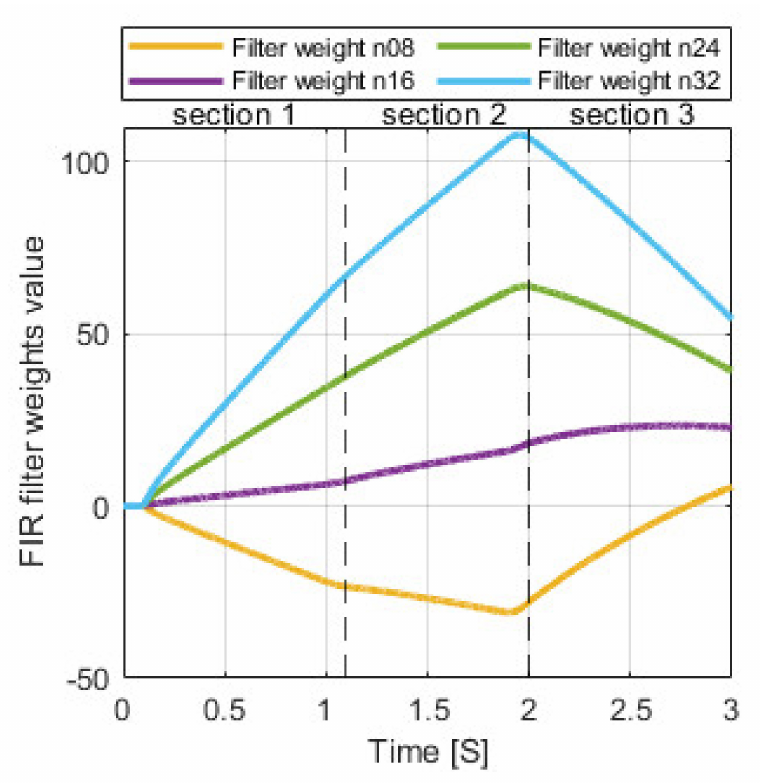
Figure 21. Limited current simulation: weight trend in FIR discrete